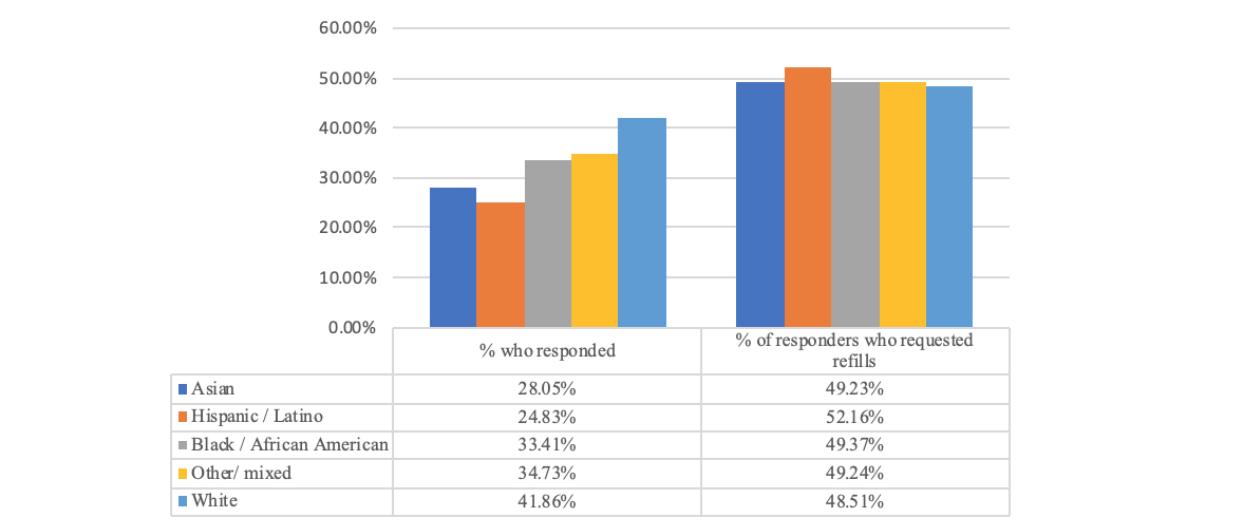
Request rate, %Refills requested, nDate of birth valida-